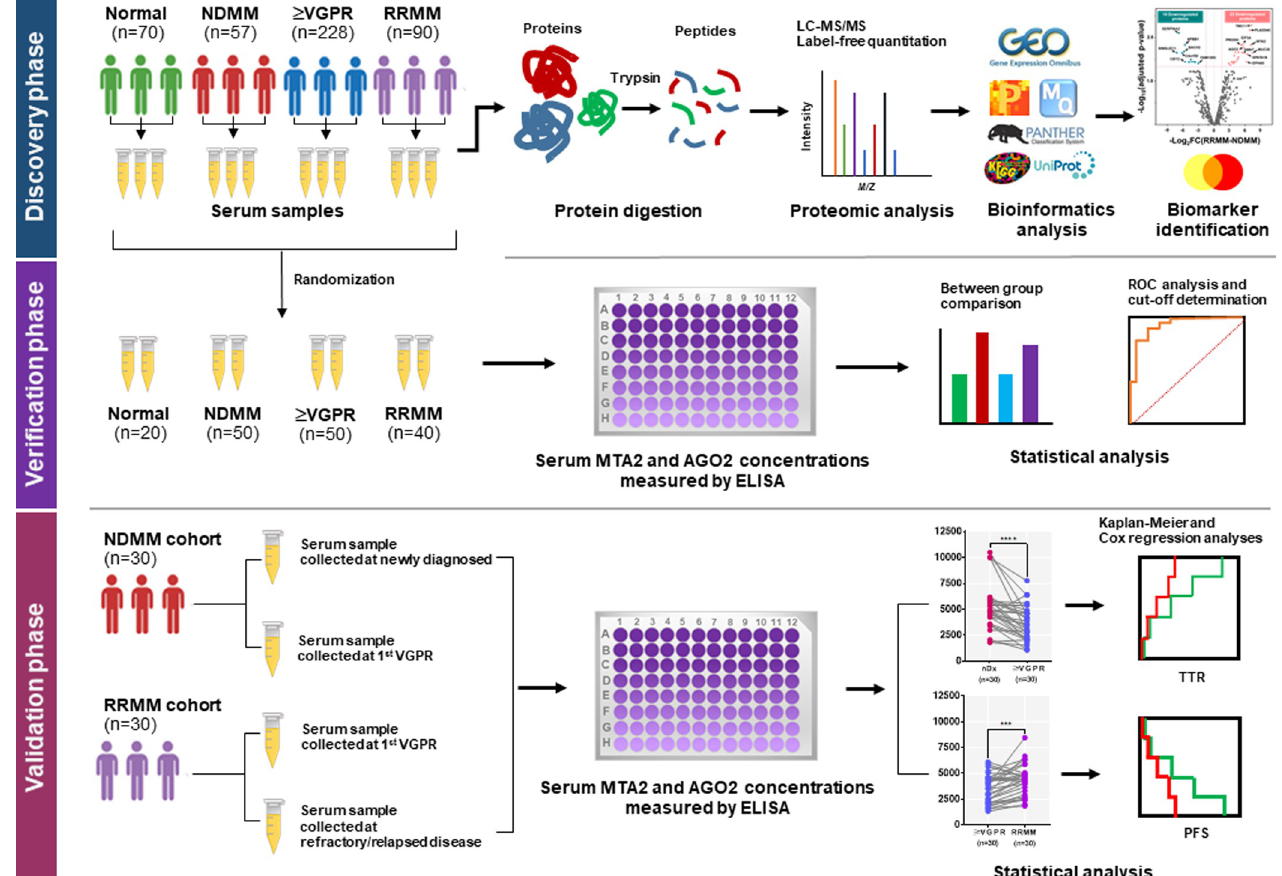
Fig 1. Schematic diagram demonstrating the experimental workflow in this study.